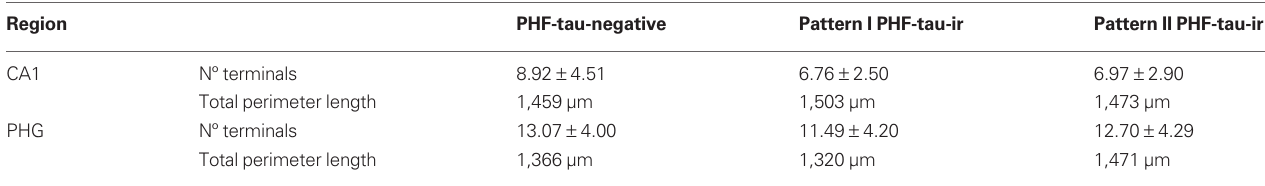
Table 4 | Comparison of the number of VGAT-immunoreactive perisomatic boutons per 100 μm of the perimeter (mean ± SD) of PHF-tau-negative neurons, and of type i and ii PHF-tau-ir neurons, in CA1 field and parahippocampal gyrus (PHG; that includes the entorhinal and the perirhinal cortex) of patient P7.